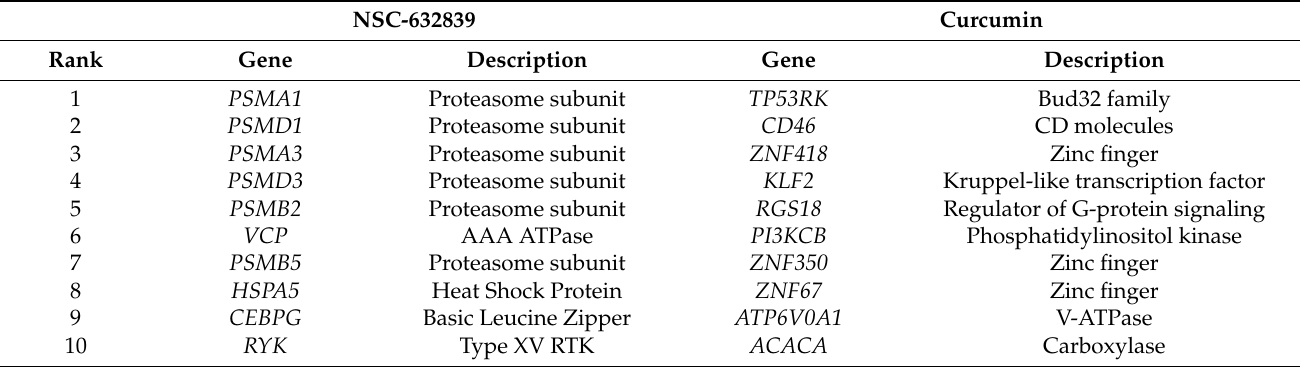
Table 2. Top gene knockdown expression profiles showing the greatest connectivity with F6 or